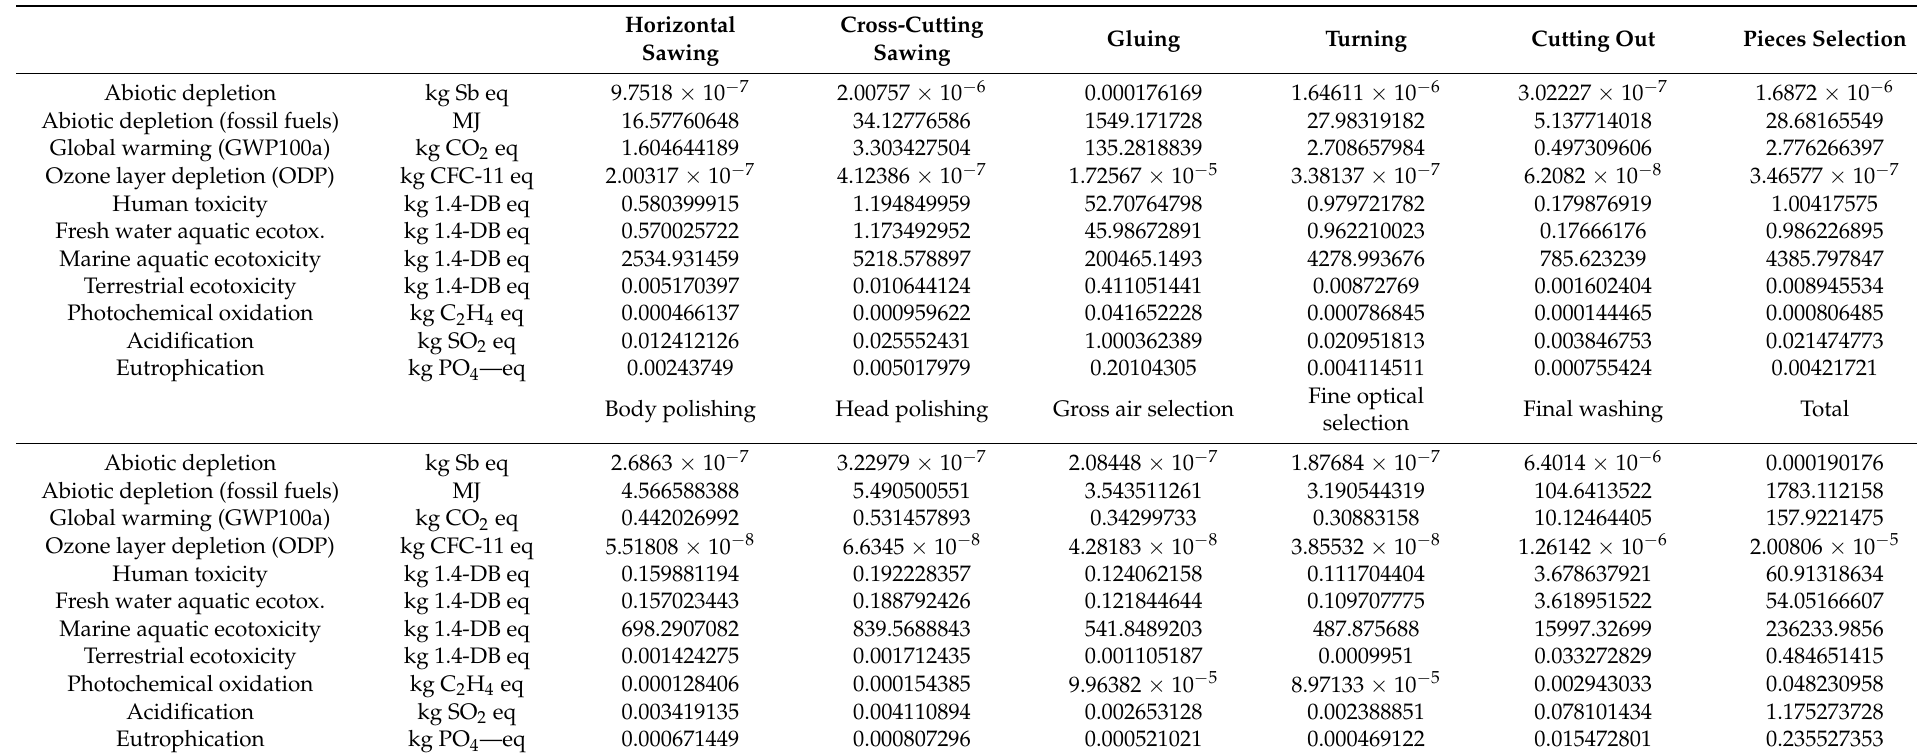
Table 12. Impact of stage 2 broken down by activities for the manufacturing process of 2-piece turned stoppers of 24 mm diameter and 44 mm in length. Horizontal